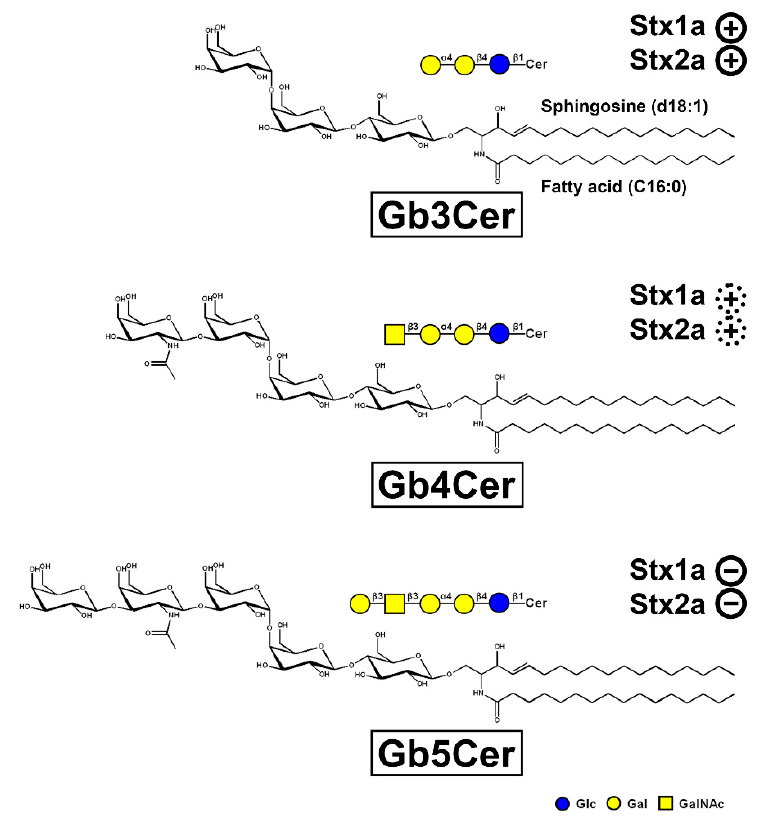
Figure 2. Tri-, tetra-, and pentahexosylceramides of the globo-series. The three GSLs are exemplarily portrayed with a ceramide (Cer) moiety carrying sphingosine (d18:1) and a C16:0 fatty acyl chain. The GSLs were drawn with the program ChemDraw 2019, Version 19.1.1.21 (PerkinElmer Informatices, Inc., Waltham, MA, USA) and the sugars are depicted in the chair conformation. Declining adhesion strength of Stx1a and Stx2a along with increasing sugar chain length of the globo-series glycans is indicated: strong binding of Stx1a and Stx2a to Gb3Cer ( ), weak binding to Gb4Cer ( ), and no binding at all to Gb5Cer ( ).